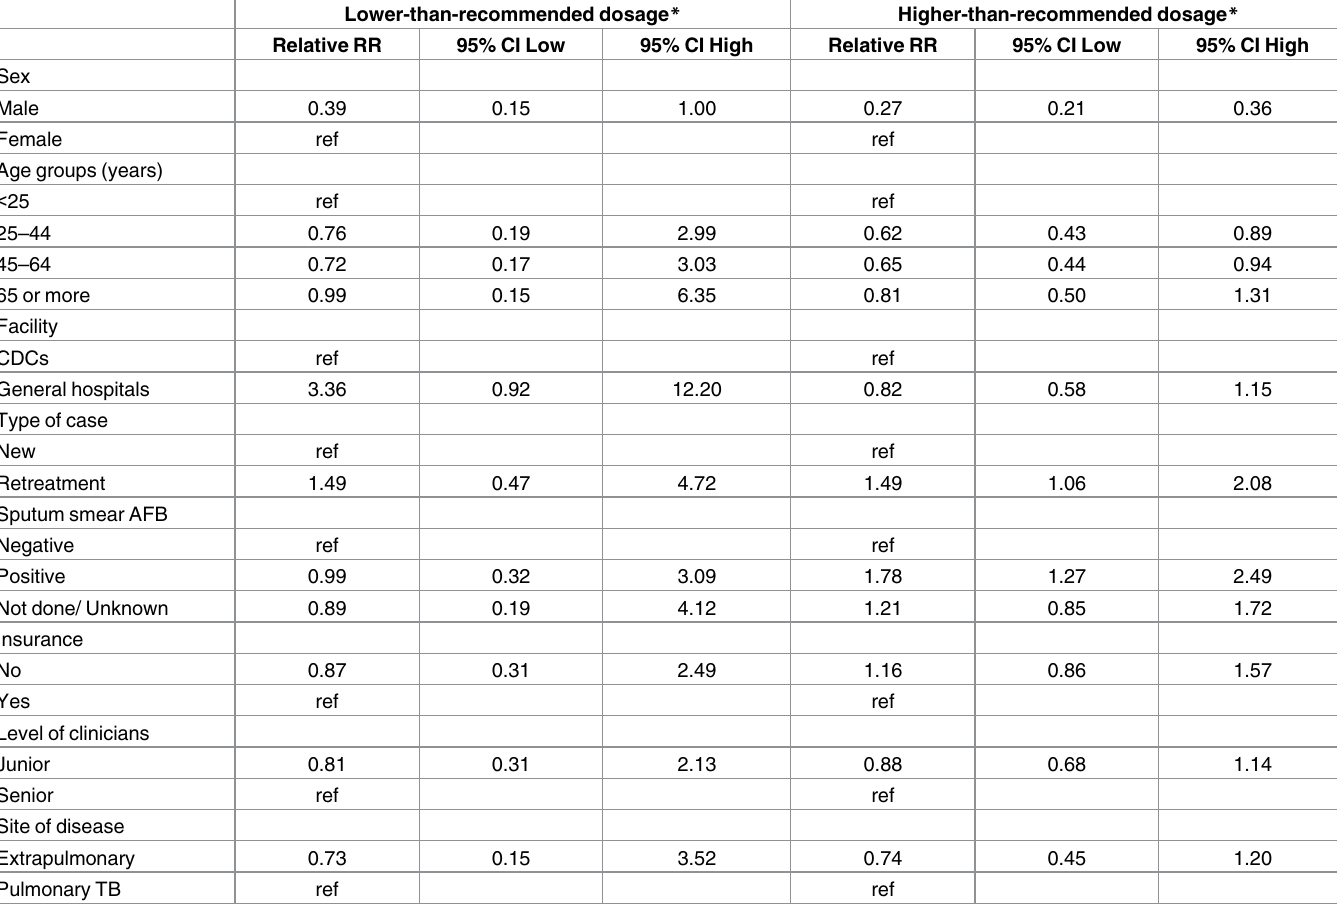
Table 7. Factors associated with inadequate dosing of Isoniazid,